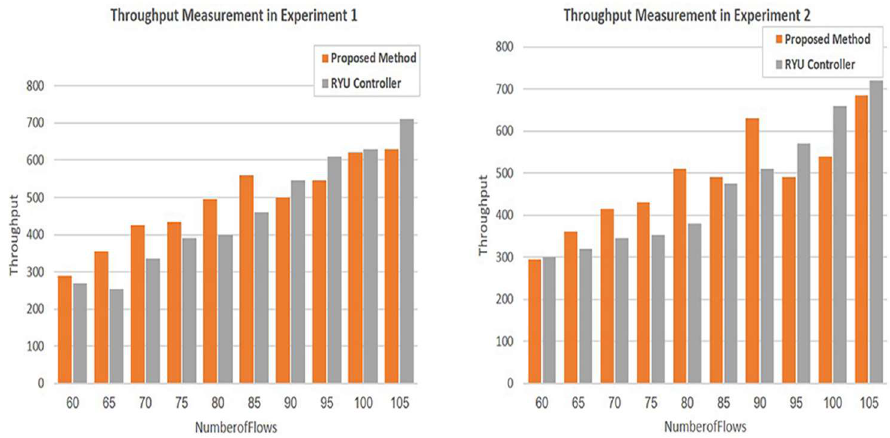
Figure 13. Comparison of Throughput Between the Proposed Method and the Ryu Controller for the Two Types of Flows in Two Experiments.